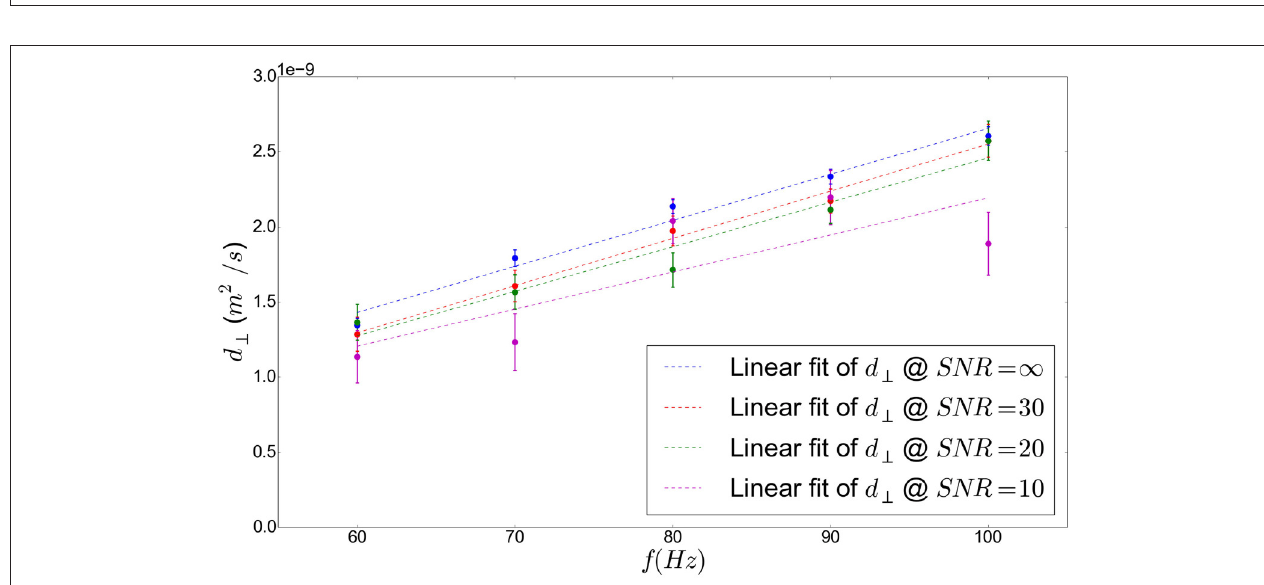
FIGURE 8 | Frequency-dependent perpendicular diffusivity in the extracellular space measured by performing Monte-Carlo simulations with diffusing particles in the extracellular space of configuration C1 (see Table 2 ), plotted against the frequency of the employed OGSE-CT sequence. A linear fit is also plotted which shows the linear dependence of diffusivity to